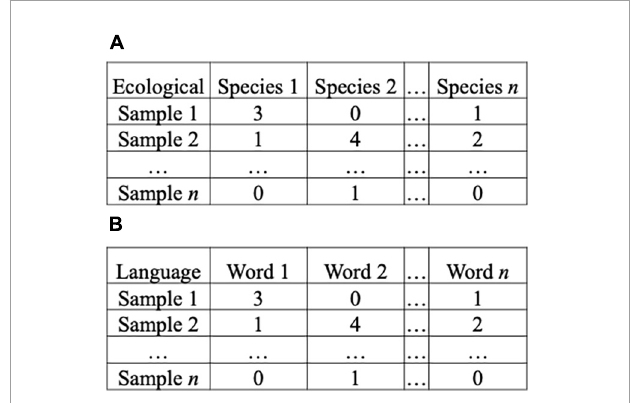
FIGURE2 Sample matrices. (A) For ecological data matrices, samples are rows, while species are columns. Values in individual cells are the frequency of the given species in the sample. (B) In this example, each response is a row, while each word is a column. Values in cells are the frequency of a word within the